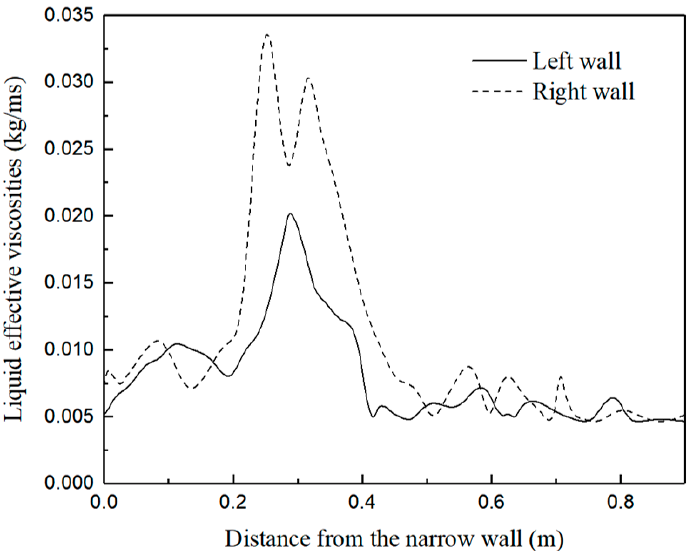
Figure 17. Effective viscosity of the turbulent flow along the centerline at both sides of the mold at the asymmetric stage.